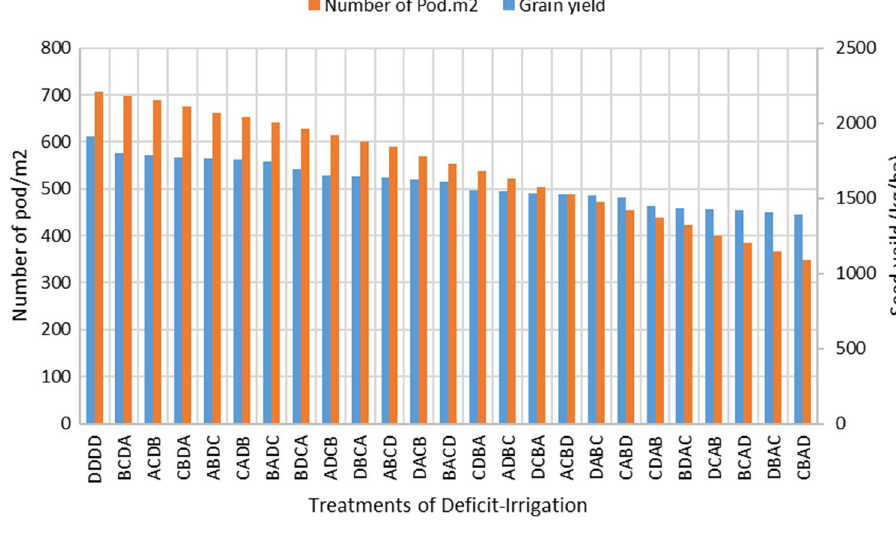
Fig. 1 Mean values of